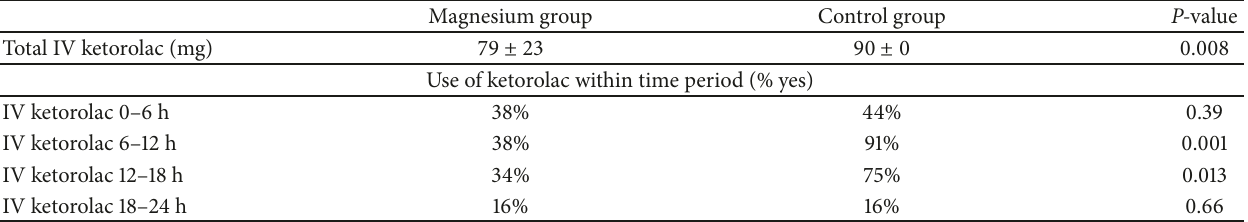
Table 2: Intravenous ketorolac requirement in first 24 hours following caesarean delivery in the magnesium and control groups.